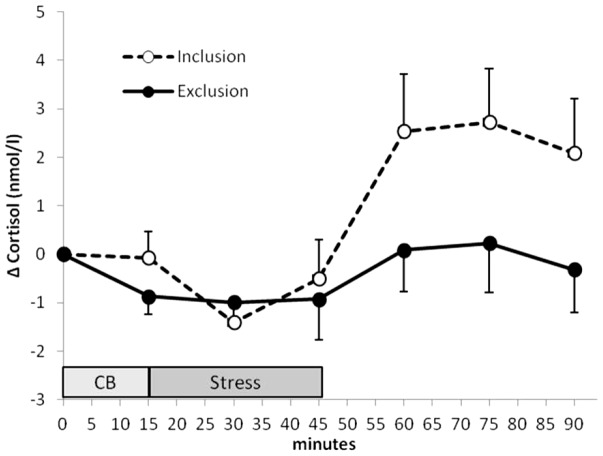
Salivary cortisol concentrations.Means and SEMs of differences from baseline of salivary cortisol concentrations (Δ = difference from baseline). Repeated Measures Analyses of Covariance reveal a significant Cyberball x time interaction (F = 3.771; p = .013). For baseline value see Table 1.